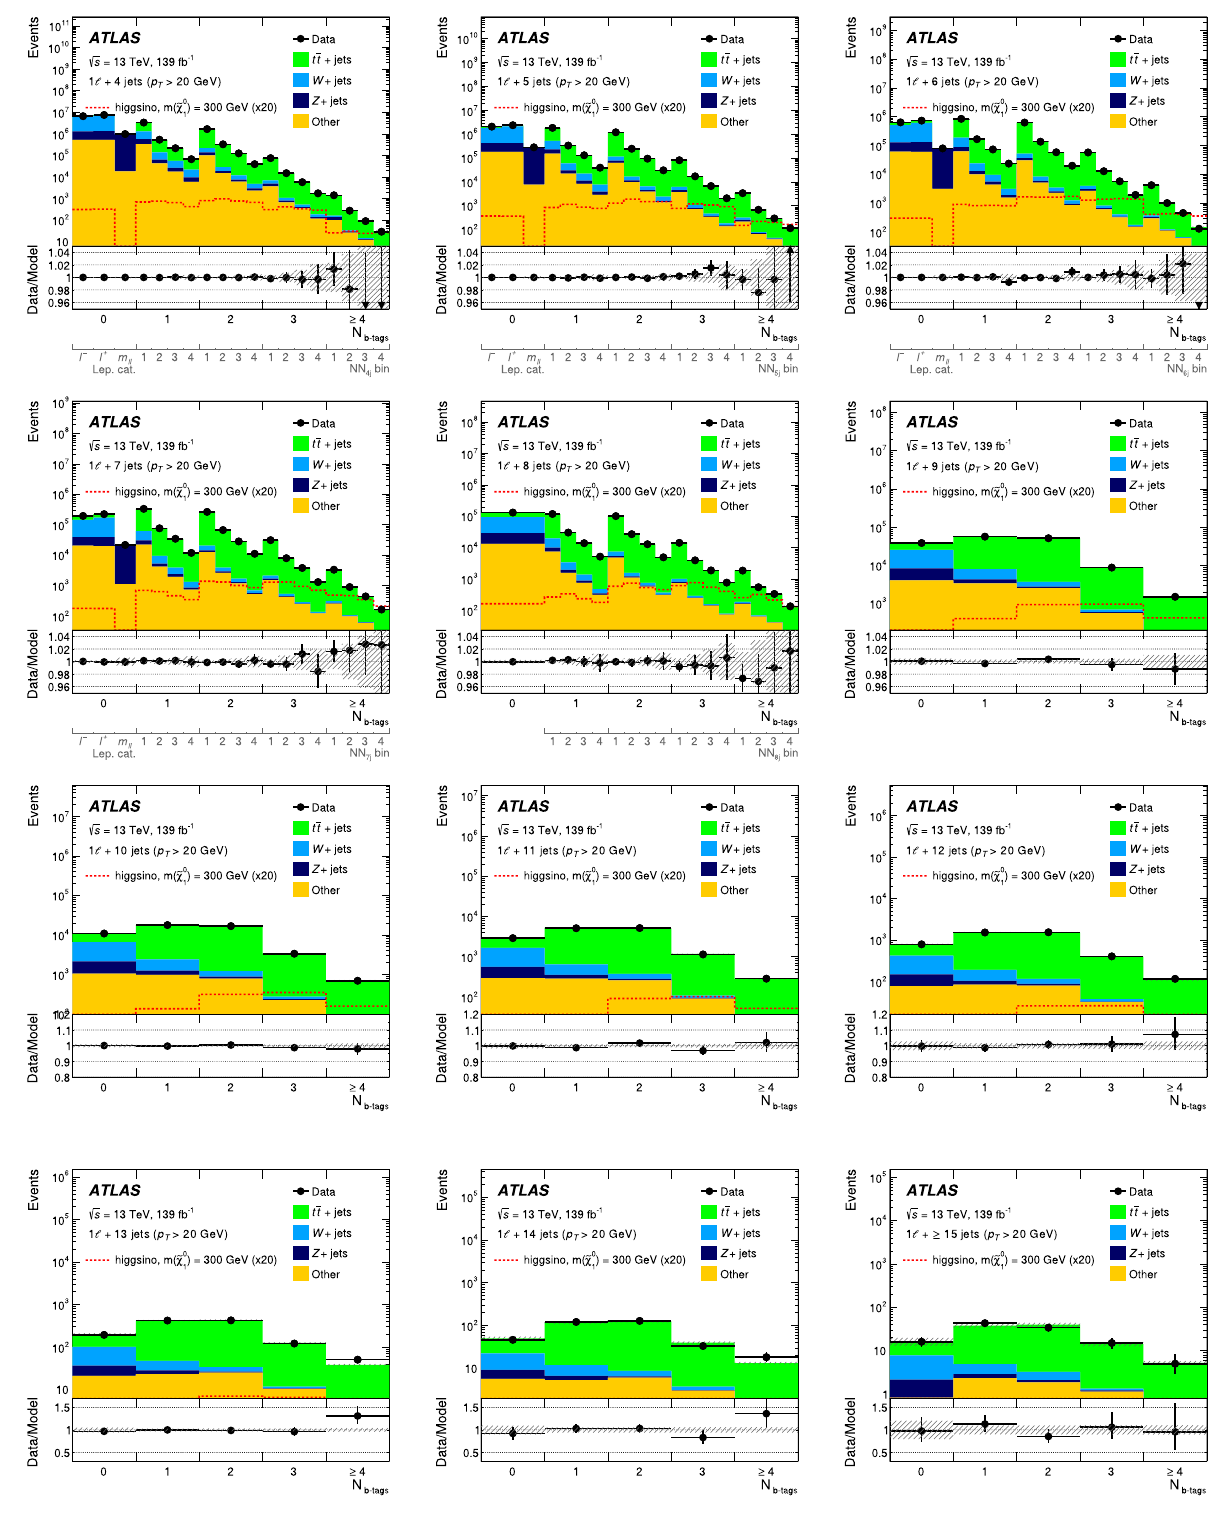
Fig. 5 The observed data event yields and the corresponding estimates for the backgrounds in the different b -jet multiplicity bins for the 20 GeV jet- p T threshold regions defined for the EWK analysis in the 1 (cid:3) category. The background shown is estimated by including all bins in